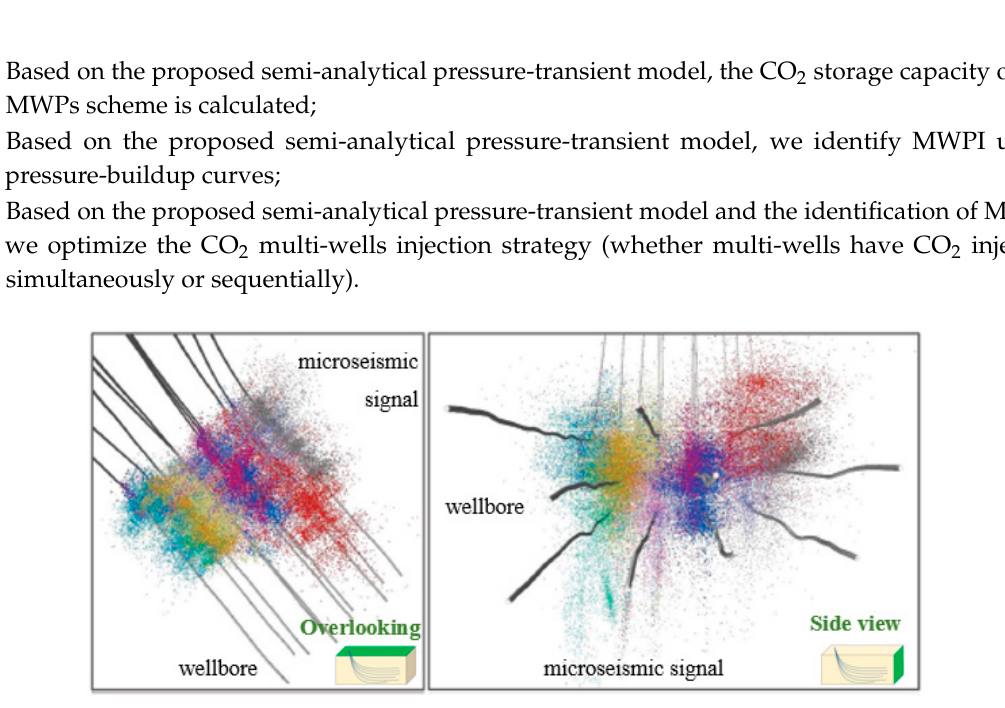
Figure 1. Micro-seismic imaging of MWPs shows fractures extending between wells.